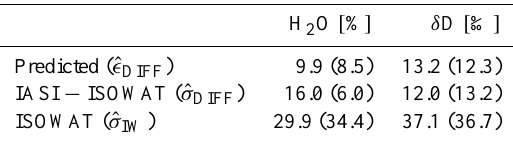
Table 1. Scatter values as obtained from IASI and ISOWAT coinci- dences that fulfil our coincidence criteria (presents the same as the left panels of Figs. 7 and 9, but for IASI instead of FTIR and at 5km altitude only). Predicted: combined ISOWAT and IASI estimated uncertainties ( ˆ (cid:15) DIFF ); IASI − ISOWAT: scatter as observed in the difference between ISOWAT and IASI ( ˆ σ DIFF ); ISOWAT: scatter as observed in the ISOWAT data ( ˆ σ IW ). The values in parenthesis are for calculations without considering the three outliers on